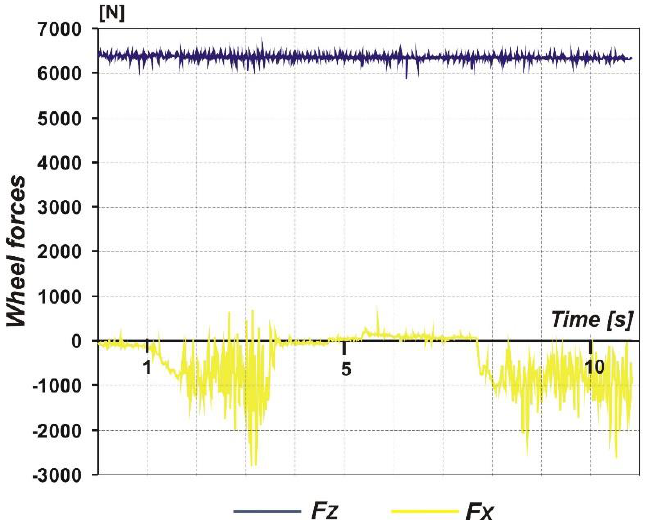
Figure 9. Sample result of the measurements: Time courses of wheel forces acting on the landing gear wheel.